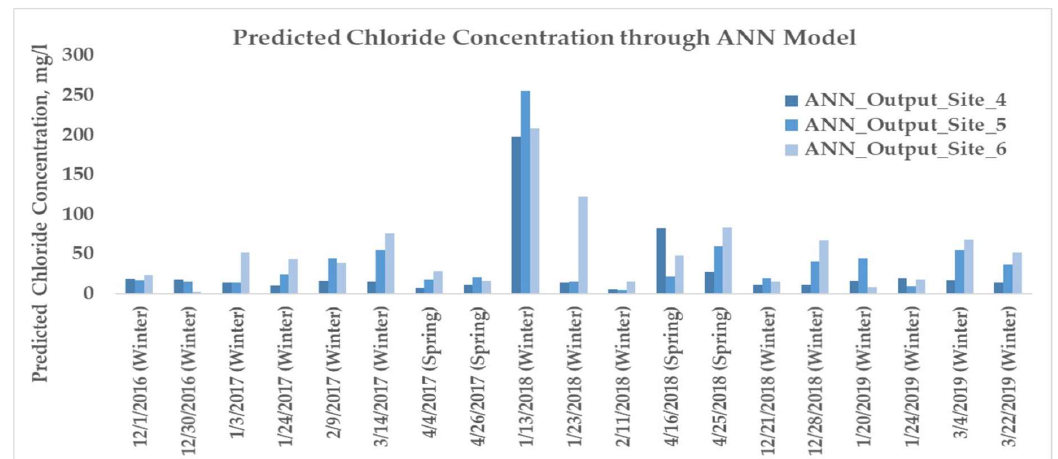
Figure 9. Predicted concentrations for three sites 4, 5, and 6 reflecting heavy Cl inventory in Winter 2018.